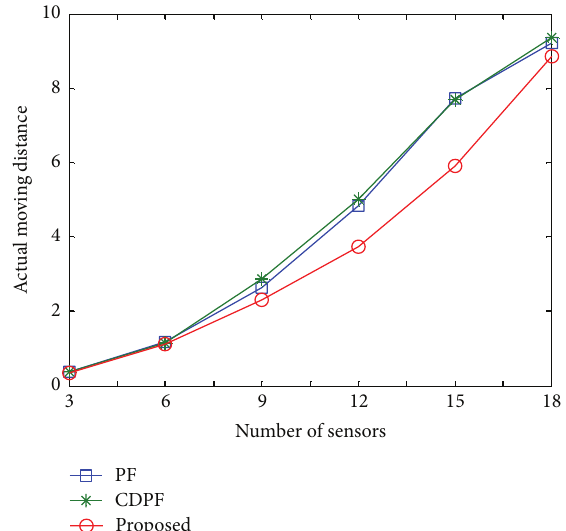
Figure 10: Actual moving distance versus number of sensors.